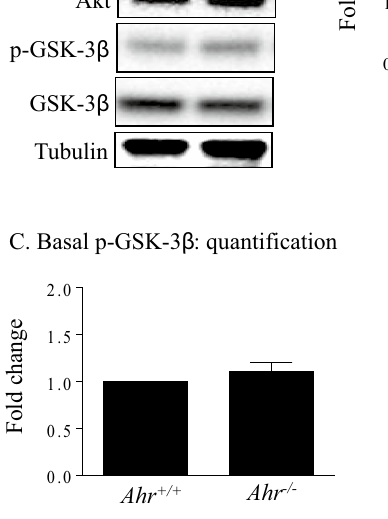
Figure 4. Basal Akt and GSK-3β phosphorylation in Ahr +/+ and Ahr −/− MLFs. Ahr +/+ and Ahr −/− MLFs were serum-starved for 18 h and cellular protein was collected for Western blot analysis of Akt and GSK-3β phosphorylation. ( A ) Representative western blot is shown and is representative of six independent experiments. ( B , C ) Densitometric analysis of basal ( B ) Akt and ( C ) GSK-3β phosphorylation in Ahr +/+ and Ahr −/− MLFs. Densitometric values of phosphorylated proteins were normalized to that of their corresponding total proteins and are expressed as fold changes relative to that of the Ahr +/+ group. Results are expressed as mean ± SEM (*p <